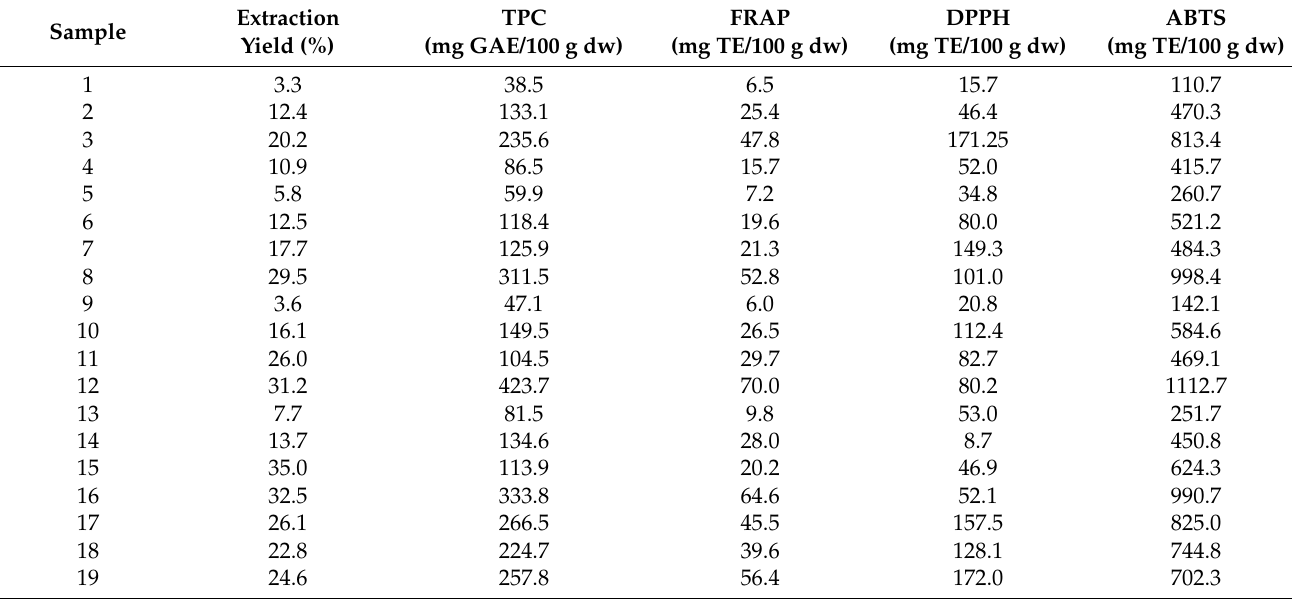
Table 1. Summary of the measured TPC, FRAP, DPPH, and ABTS values for the nineteen extracts.